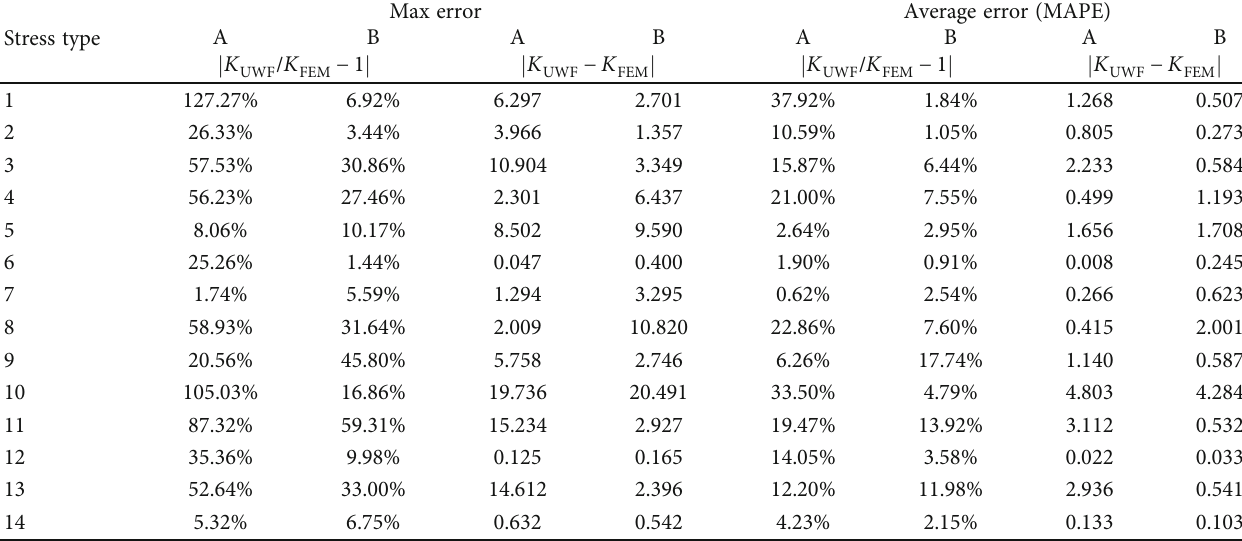
Table 2: Errors between point weight function method and fi nite element